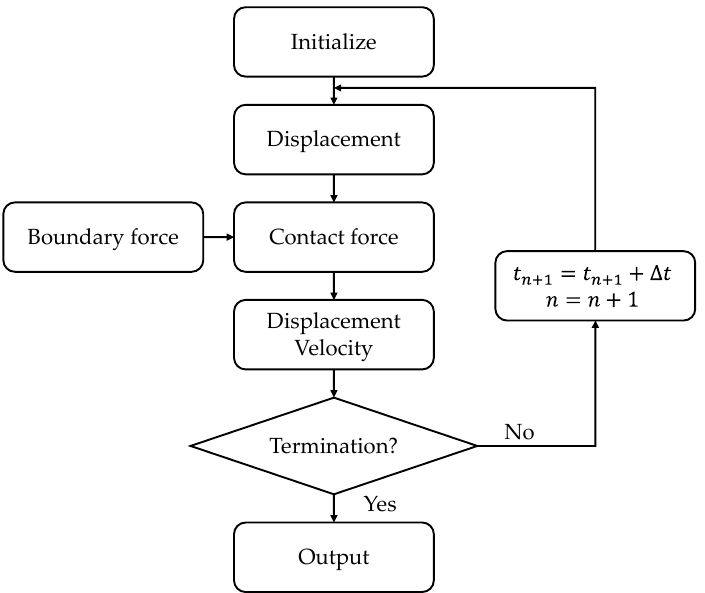
Figure 2. The procedure of FEM–DEM method.